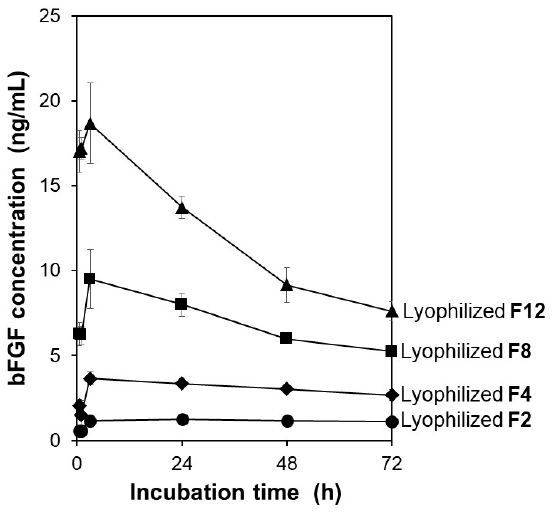
Figure 4. Variations of bFGF concentration with incubation time up to 72 h in the acellular medium supplemented with the lyophilized F2, F4, F8, and F12 membranes (average ± SD; n = 3).